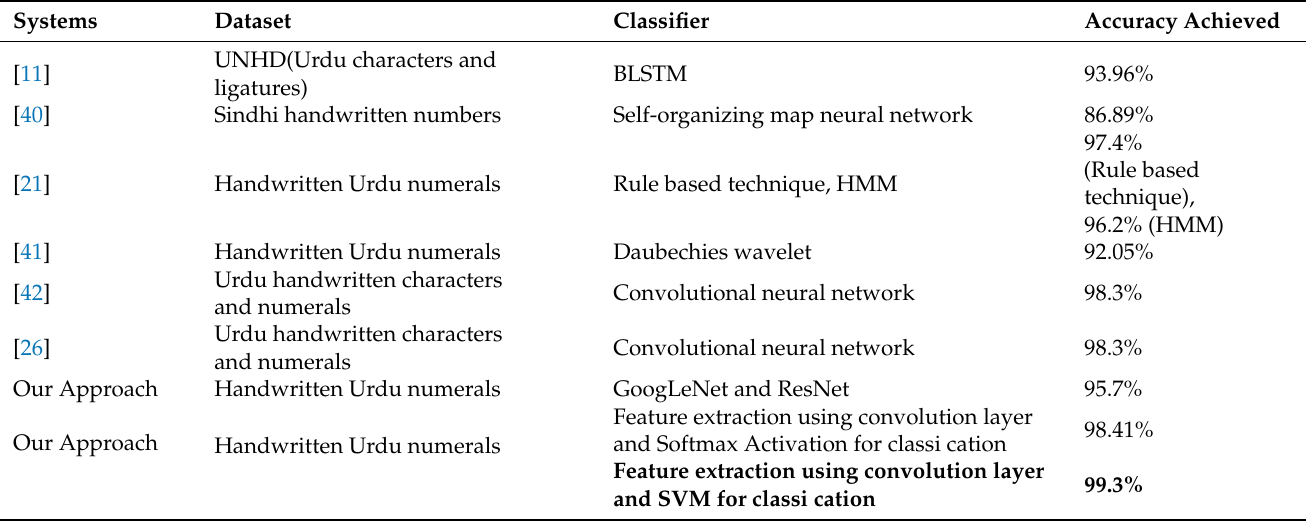
Table 3. Comparison of handwritten Urdu numerals recognition on different